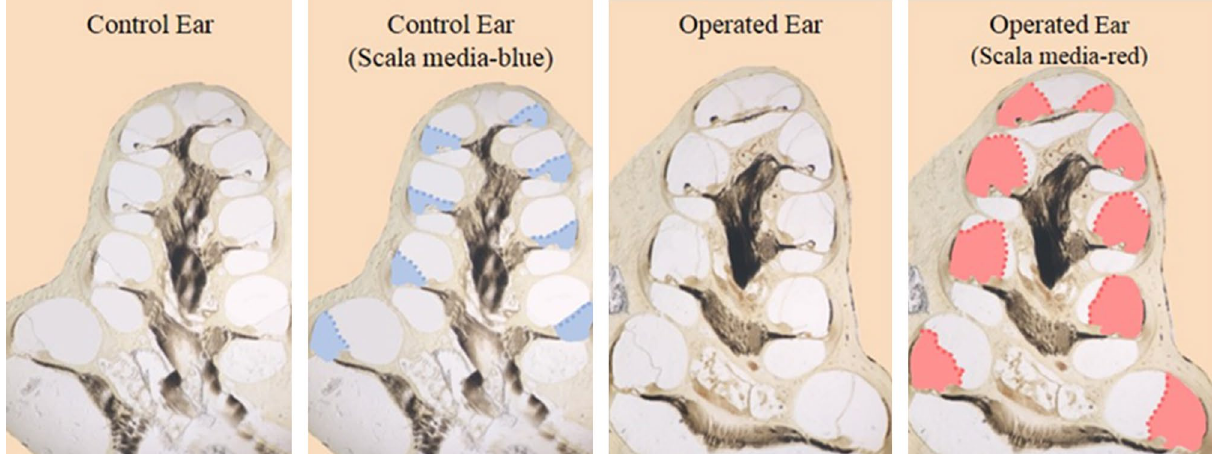
Figure 4. Mid-modiolar histological sections of representative control (left panels) and operated (right panels) cochleae of guinea pigs that underwent a surgery to ablate the right-side endolymphatic sac and create endolymphatic hydrops. Colored shading identifies the scala media of the left (blue) and right (red) ears. Scala media cross-sectional area was enlarged in the right ear, demonstrating endolymphatic